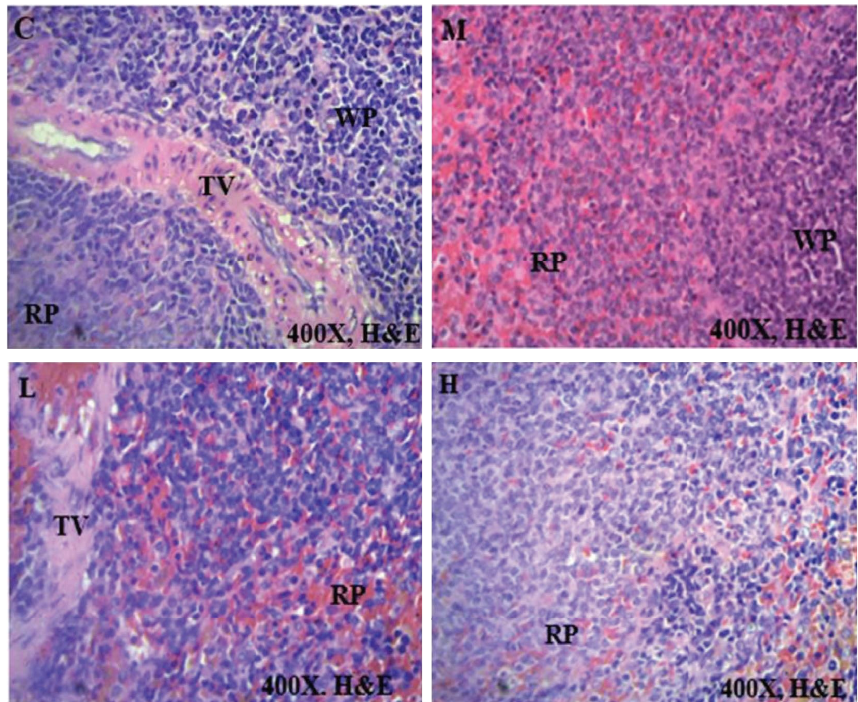
Figure 5: Efect of AAE on histological features of the splenic tissues, C : control, L : 100mgkg -1 , M : 300mgkg -1 , and H : 1000mgkg -1 . WP- lymphoid follicles of white pulp, RP- vascular matrix of red pulp, and TV-trabecula vein. Te photomicrographs (H&E, x400) of the spleen tissues represent the general appearance observed in the rats treated with AAE and the control